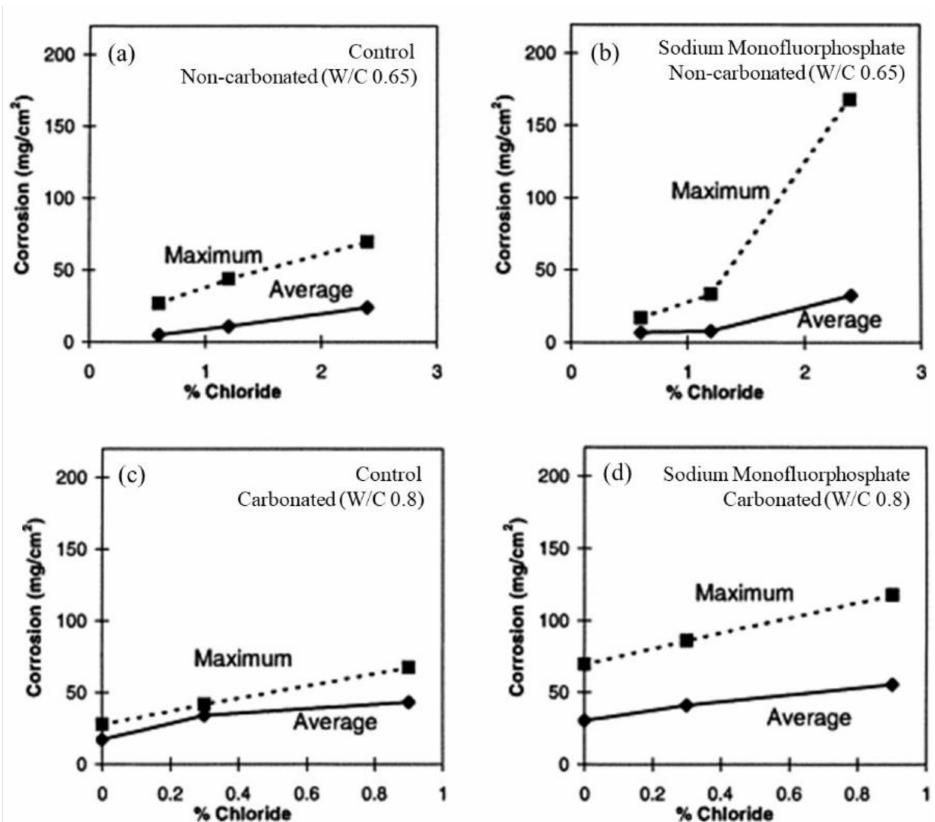
Figure 18. Average and maximum corrosion weight losses for steel bars at three cover depths in various concrete specimens: ( a ) control noncarbonated, ( b ) sodium monofluorophosphate noncarbonated, ( c ) control carbonated, and ( d ) sodium monofluorophosphate carbonated [15]. Reproduced with permission from Ngala, V. et al., Corros. Sci.; published by Elsevier,